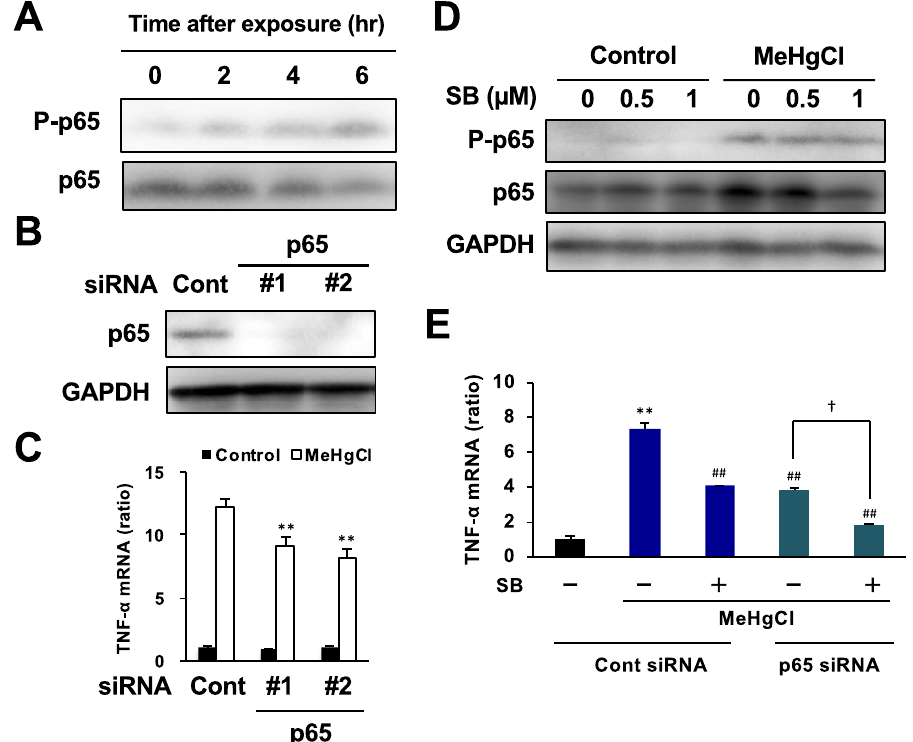
Figure 5. Involvement of NF-κB signaling in methylmercury-induced TNF-α expression via p38 in BV2 cells. ( A ) BV2 cells were exposed to MeHgCl (20 µM) for the indicated time course, then Western blotting was performed. ( B ) Cells were transfected with two different sequences of p65 siRNA (#1 or #2) and incubated for 24 h. Protein levels of p65 were determined by Western blotting. ( C ) The cells were exposed to MeHgCl (20 µM) for 6 h and mRNA levels of TNF-α were measured by qPCR (n = 3). ( D ) The cells were pretreated with indicated concentrations of SB203580 (SB; p38 inhibitor) for 30 min, then 20 µM of MeHgCl were added to the medium and incubated for a further 4 h, followed by Western blotting. ( E ) After the exposure of MeHgCl for 6 h, mRNA levels of TNF-α were measured by qPCR (n = 3). All qPCR data are shown as actin-corrected means ± standard deviations. The Y-axis indicates the ratio with the control as 1. * P < 0.01 vs control. ## < 0.01 vs SB(−) MeHgCl(+). † < 0.01 vs SB(−) p65 siRNA +